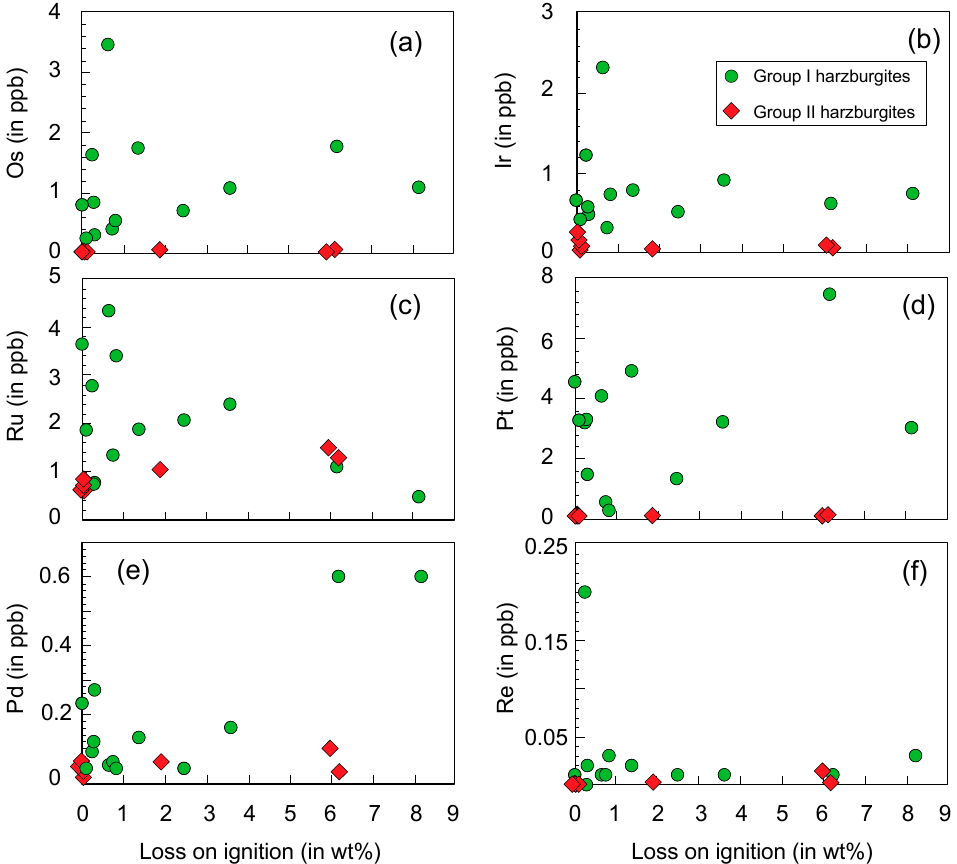
Figure 6. Loss on ignition (LOI) values versus Os ( a ), Ir ( b ), Ru ( c ), Pt ( d ), Pd ( e ) and Re ( f ) contents.